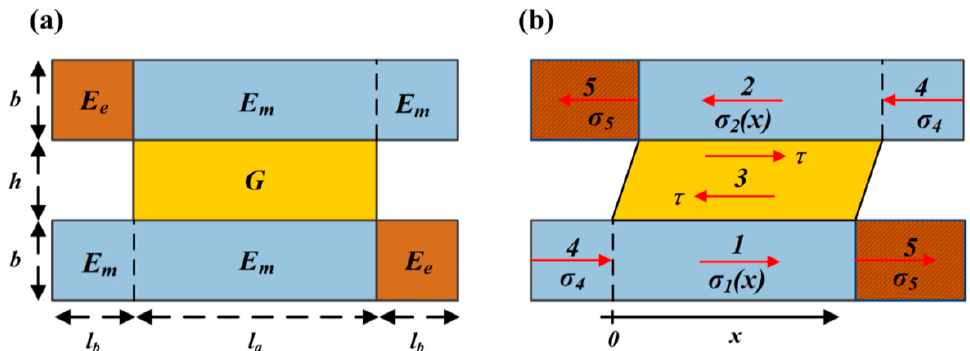
Figure 2. Schematic image of the unit cell at “phase 0”. ( a ) The geometry and material parameters are defined on the undeformed unit cell. ( b ) The region partition 1 to 5 is defined on the deformed unit cell, where Regions 1, 2 and 4 are “hard plate” material, region 3 is “share part” material and Region 5 is “joint part” material. σ i ( i = 1, 2, 4, 5 ) and τ are respectively, the normal and shear stress distributed in every region, under uniaxial tensile stress. Origin “ o ” and “ x -axis” is the coordinate defined while establishing the constitutive model.